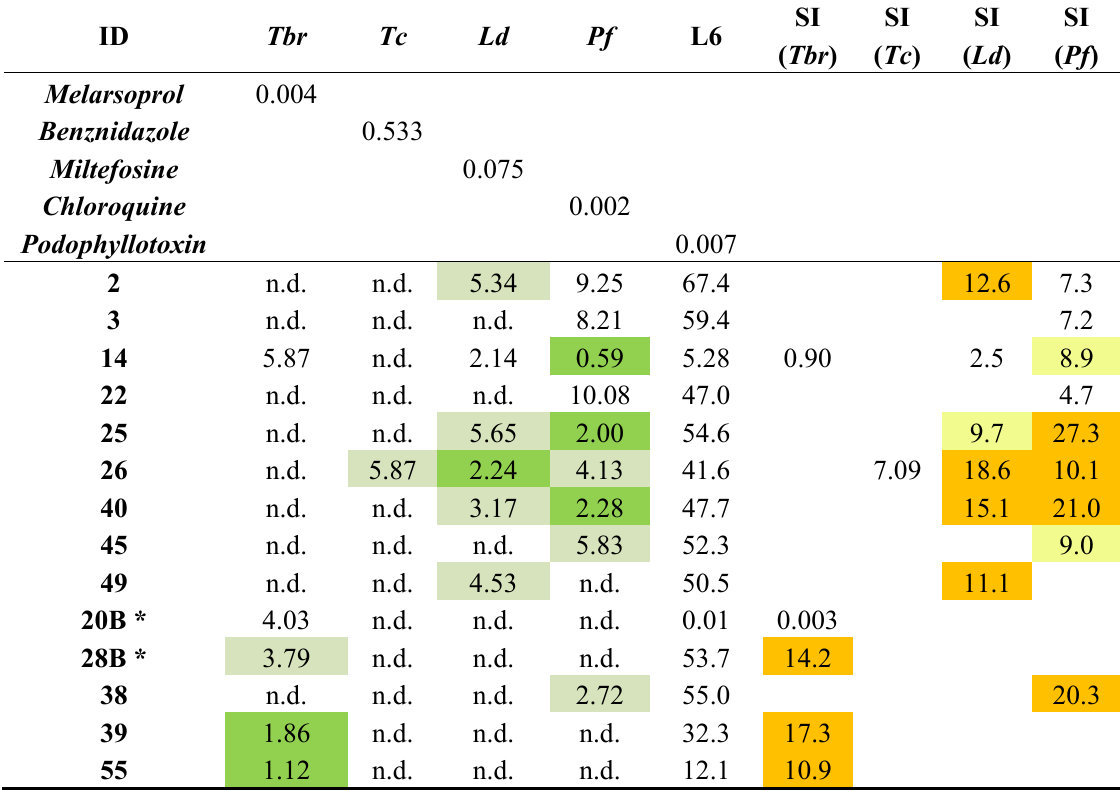
* Samples obtained with extraction method B, see Table 2; n.d.: not